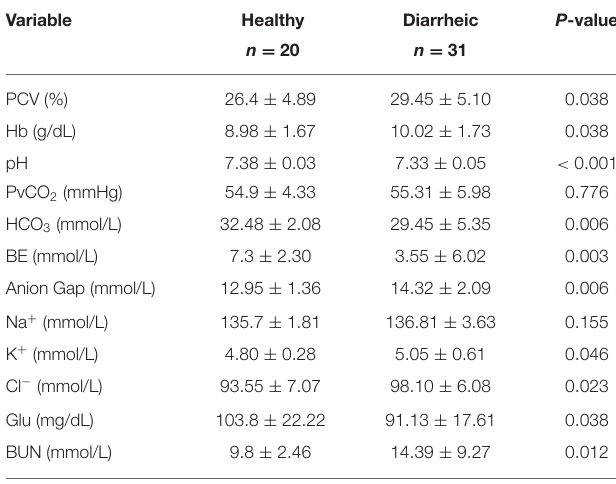
TABLE 1 | Blood gas and electrolyte analysis of healthy and diarrheic calves.